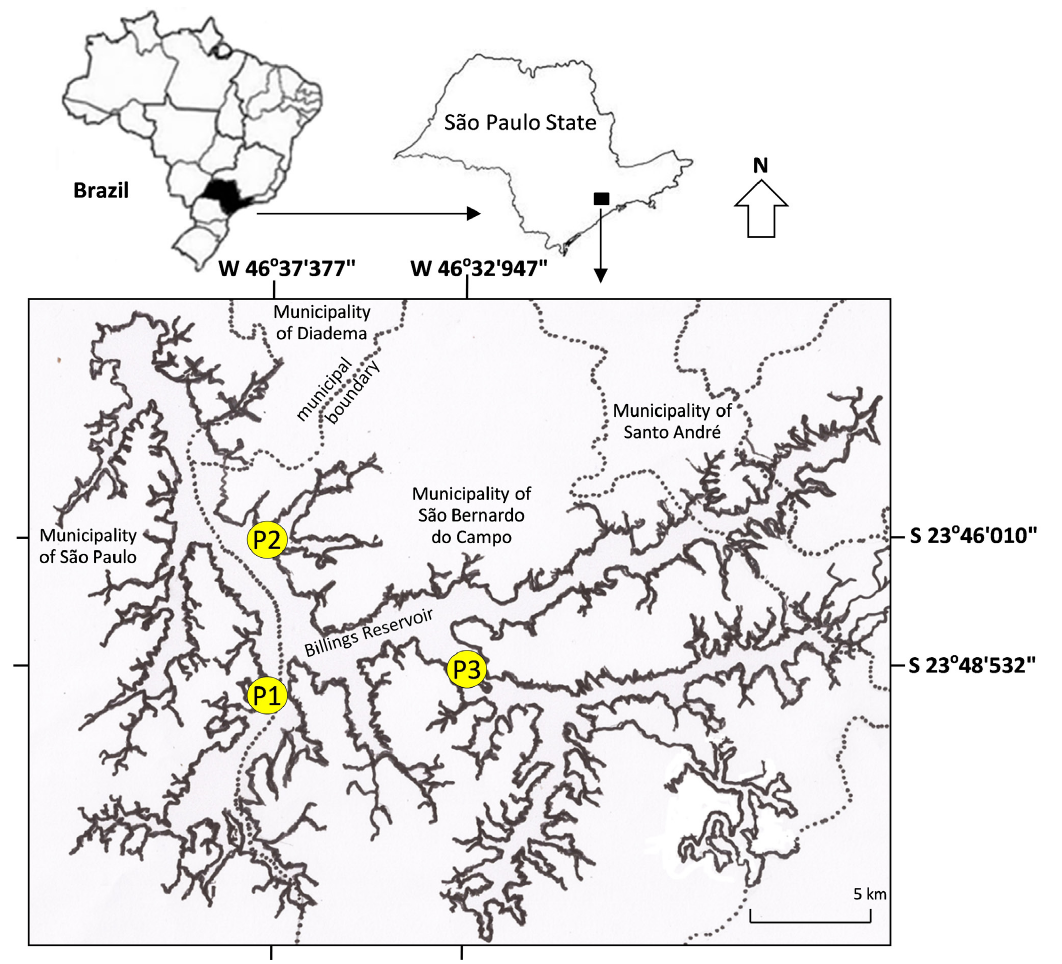
Figure 1. Study area and approximate location of sampling sites at Billings Reservoir (Southeastern region of Brazil, São Paulo State): P1 - Taquacetuba, P2 - Alvarenga and P3 - Biguás Island (dotted lines - municipal